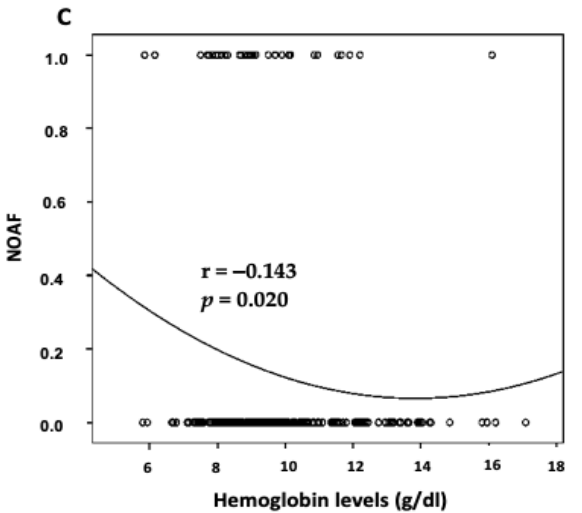
Figure 3. Correlation between serum hemoglobin levels (g/dL) and NOAF in critically ill patients during intensive care unit stay. ( A ) Spearman’s correlation coefficient (r) = − 0.086, p < 0.001 in all patients. ( B ) Spearman’s correlation coefficient (r) = − 0.098, p = 0.024 only in patients with sepsis. ( C ) Spearman’s correlation coefficient (r) = − 0.143, p = 0.020 only in patients with renal failure (NOAF, new-onset atrial fibrillation).